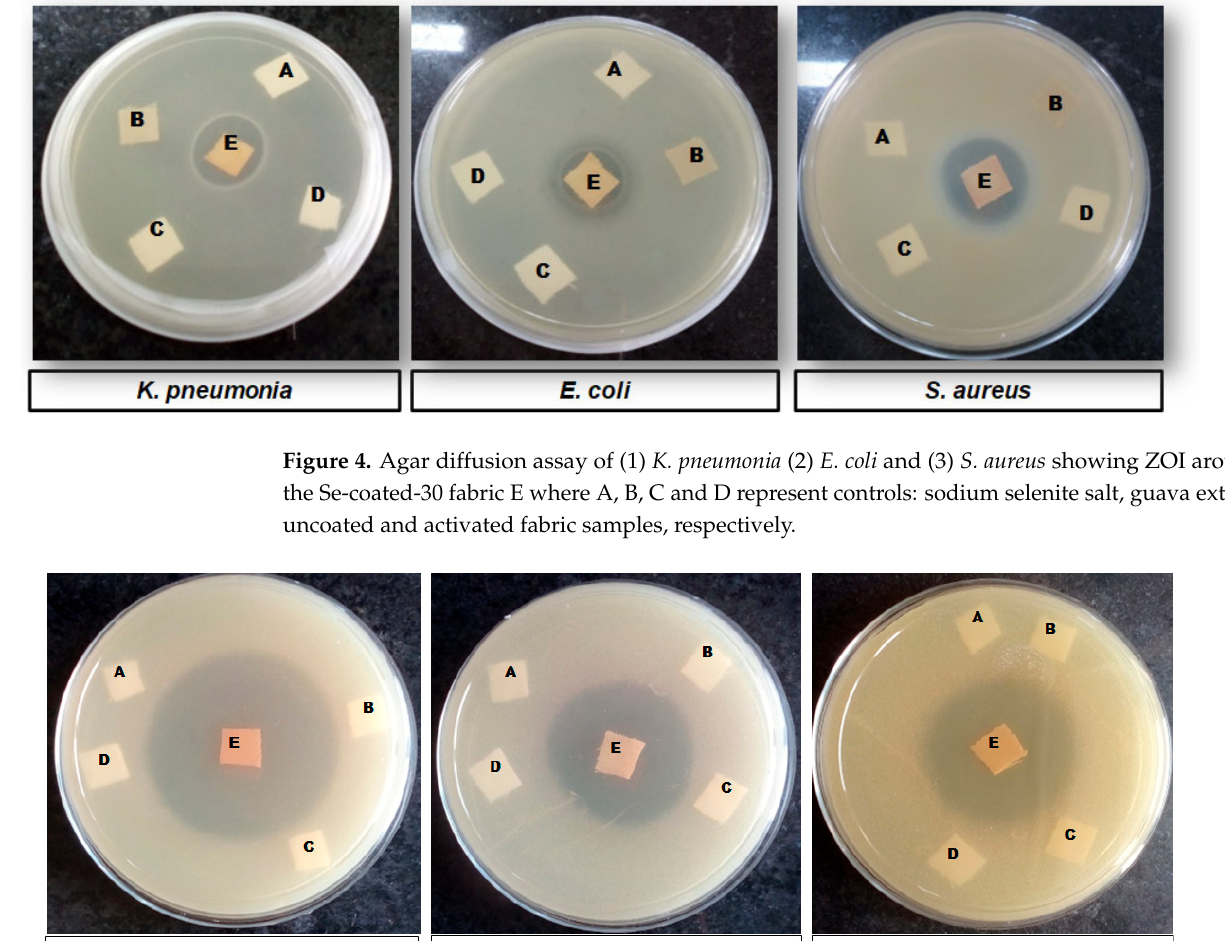
Table 2. Showing frequencies (cm − 1 ) of Uncoated, Activated and Se-coated-30 fabric samples in FTIR.